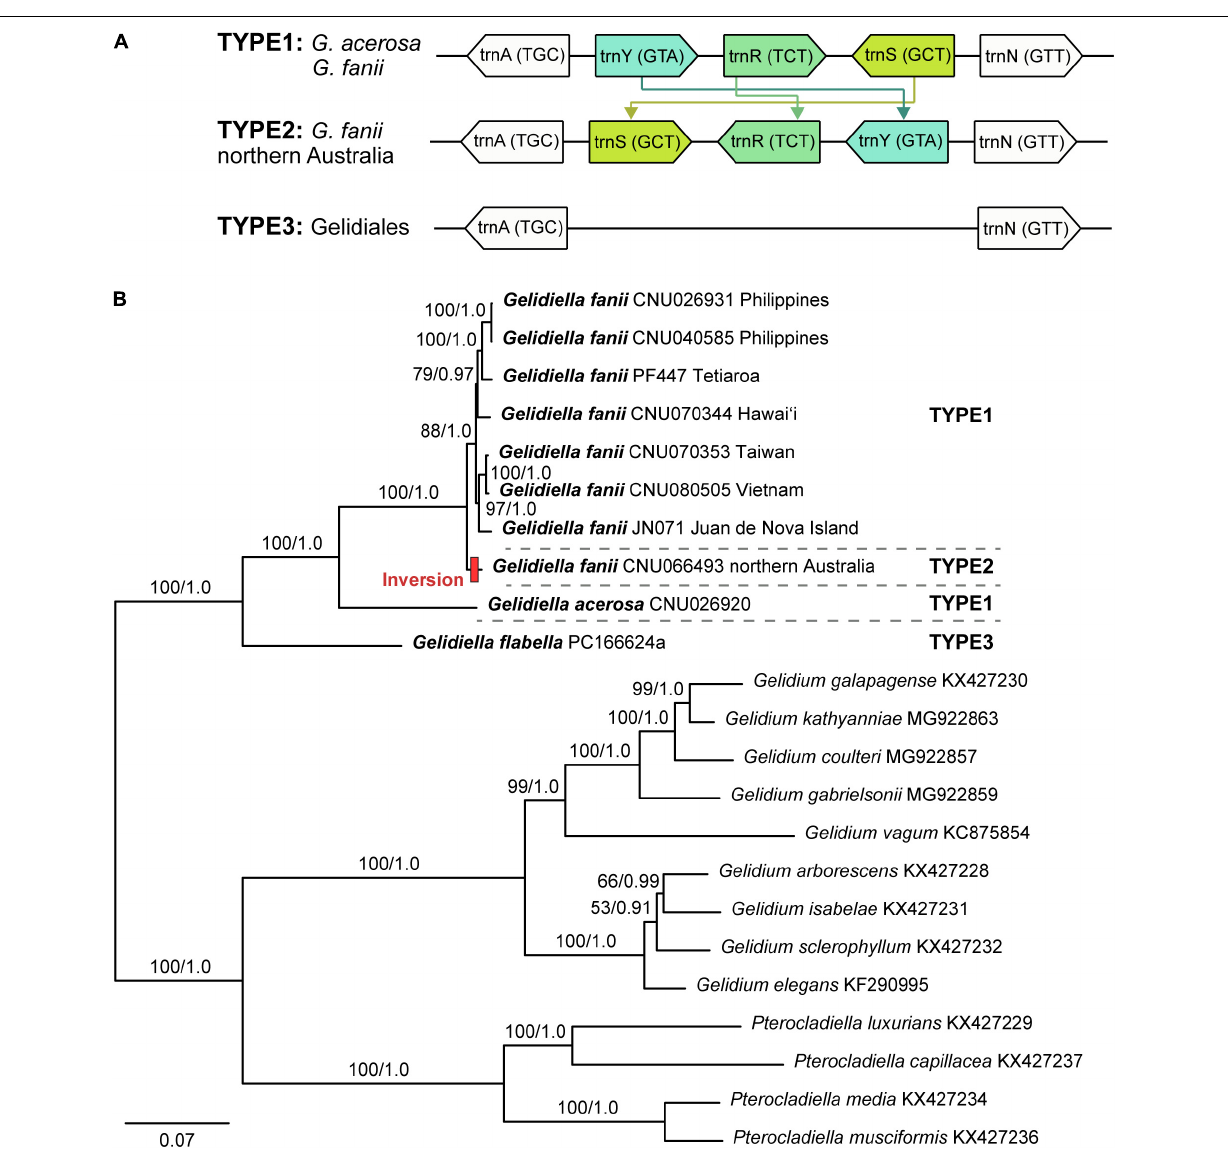
FIGURE 1 | (A) The tRNA insertion and inversion rearrangement of trn Y- trn R- trn S region in Gelidiales. (B) Maximum likelihood phylogeny of Gelidiella using 23 protein-coding genes generated in this study and previously published data of the Gelidiales. Both ML bootstrap values ( ≥ 50%) and Bayesian posterior probabilities ( ≥ 0.9) are indicated near branches. Bold letter indicates newly generated sequences in this study. Red bar indicates tRNA inversion rearrangement inferred by CREx